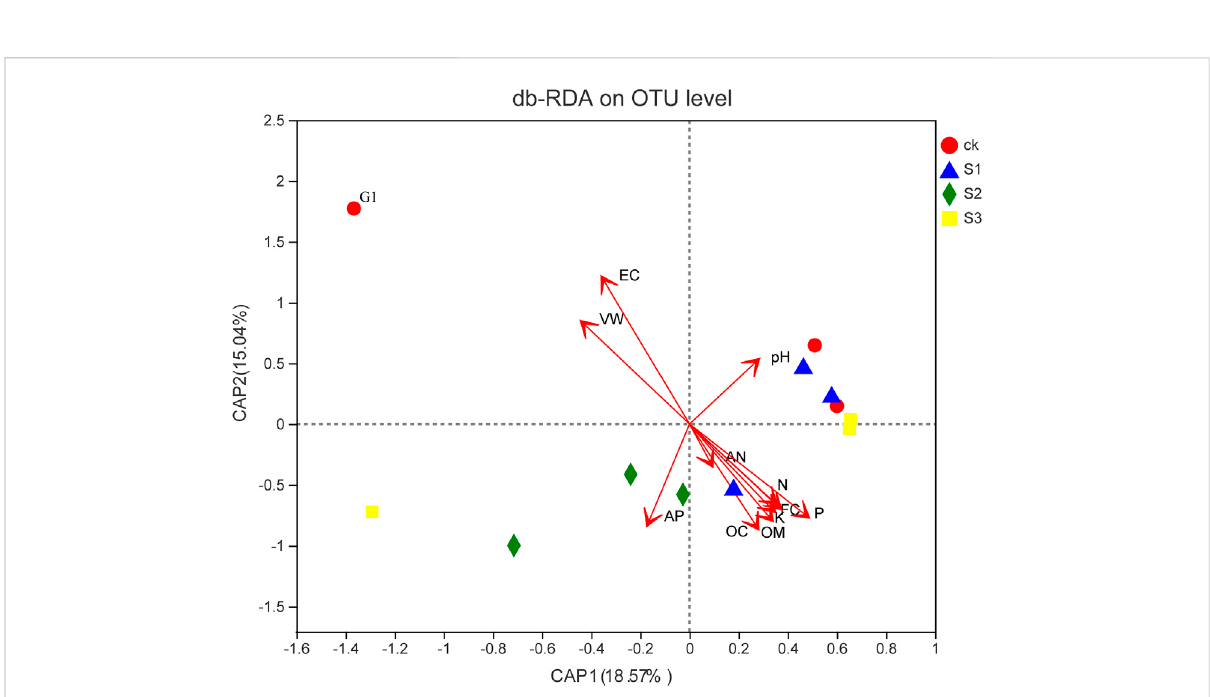
FIGURE 7 db-RDA of the relationshipbetweensoil characteristics and soil bacterial community. Two fi rst components (PCoA 1 and PCoA 2) were plotted and represent 23.61% of the